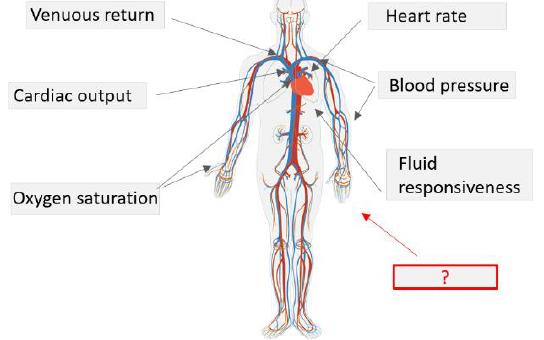
Figure 1. While work aimed at refining measurements of standard parameters is unarguably of great relevance for peri-operative and critical care, a pressing need exists for complementing such established parameters with additional hemodynamic indices. Such indices however are slow to find their way to standard clinical diagnosis and treatment